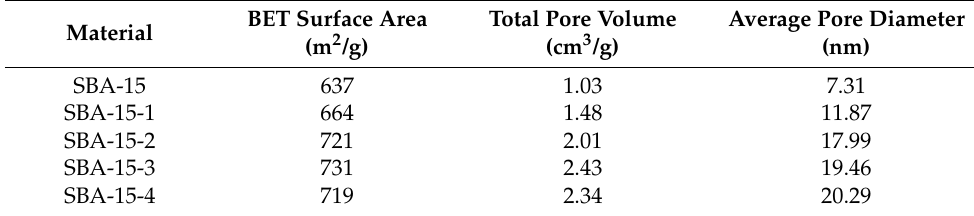
Figure 3. Nitrogen sorption isotherms ( a ) and pore size distribution ( b ) of SBA-15 particles with different pore sizes. Table 1. Textural parameters of SBA-15 particles with varying pore size.